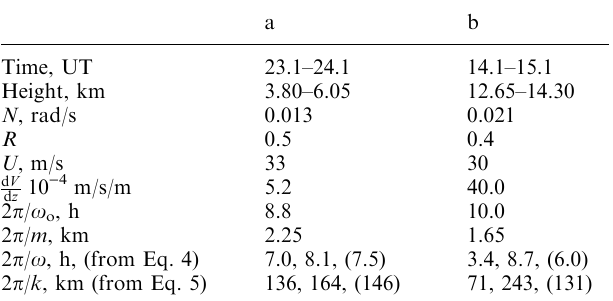
Table 1. Estimated magnitudes of wave